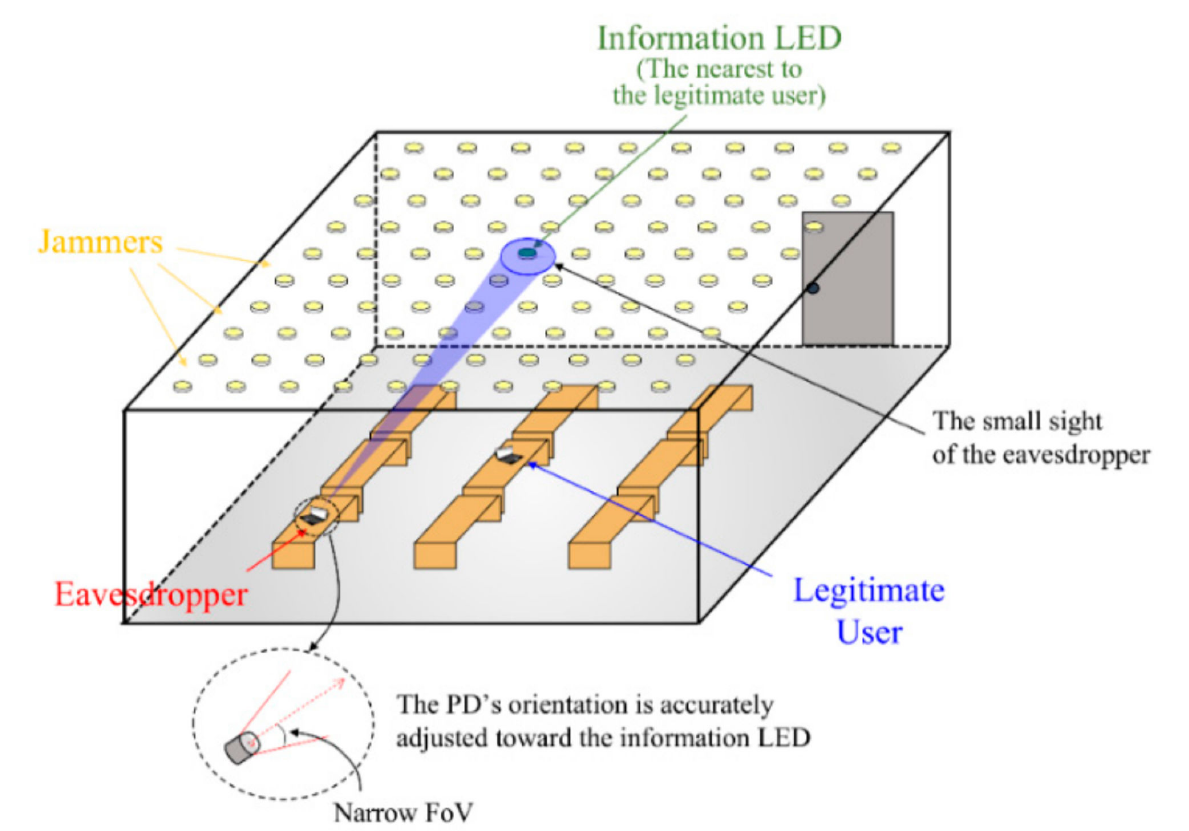
Figure 6. Diagrammatic illustration of artificial jamming in VLC